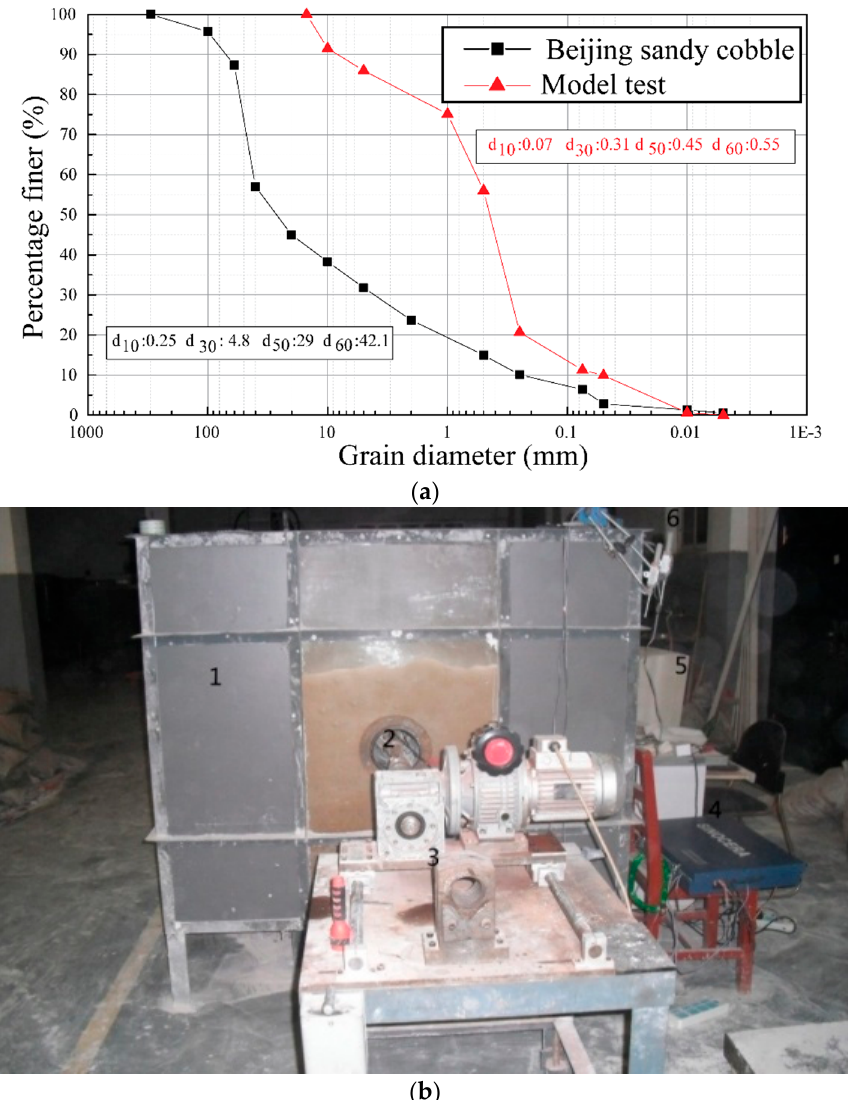
Figure 11. Overview of the 1 g model test: ( a ) Gradation of the soil material used in the 1 g model test (d stands for the maximum diameter of one single particle); and ( b ) prototype of the model [32].